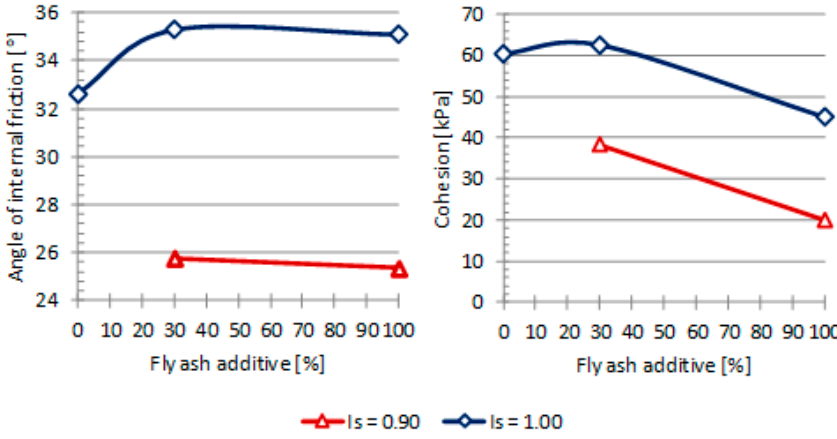
Figure 7. Changes in the angle of internal friction and cohesion depending on the fly ash addition.